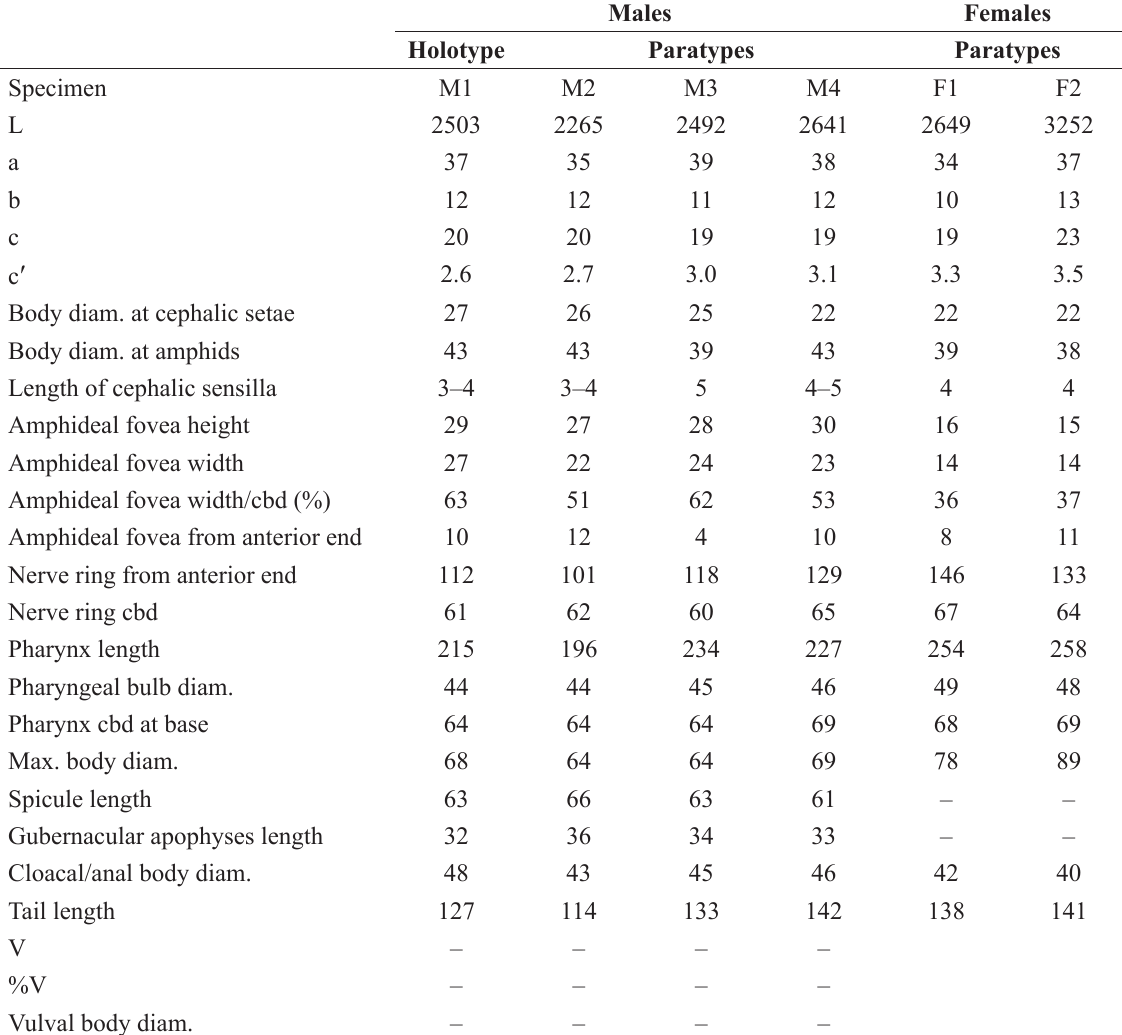
Table 7. Morphometrics (µm) of Desmodora parapilosa sp. nov. Abbreviations: a = body length/ maximum body diameter; b = body length/pharynx length; c = body length/tail length; cʹ = tail length/ anal or cloacal body diameter; cbd = corresponding body diameter; L = total body length; V = vulva distance from anterior end of body; %V = V/total body length ×